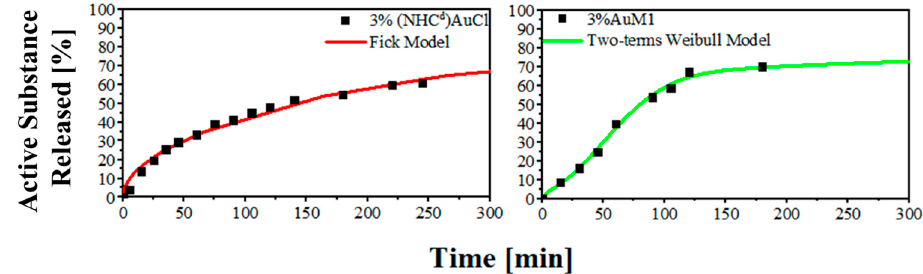
Figure 7. Release kinetic in the first region of the curves.